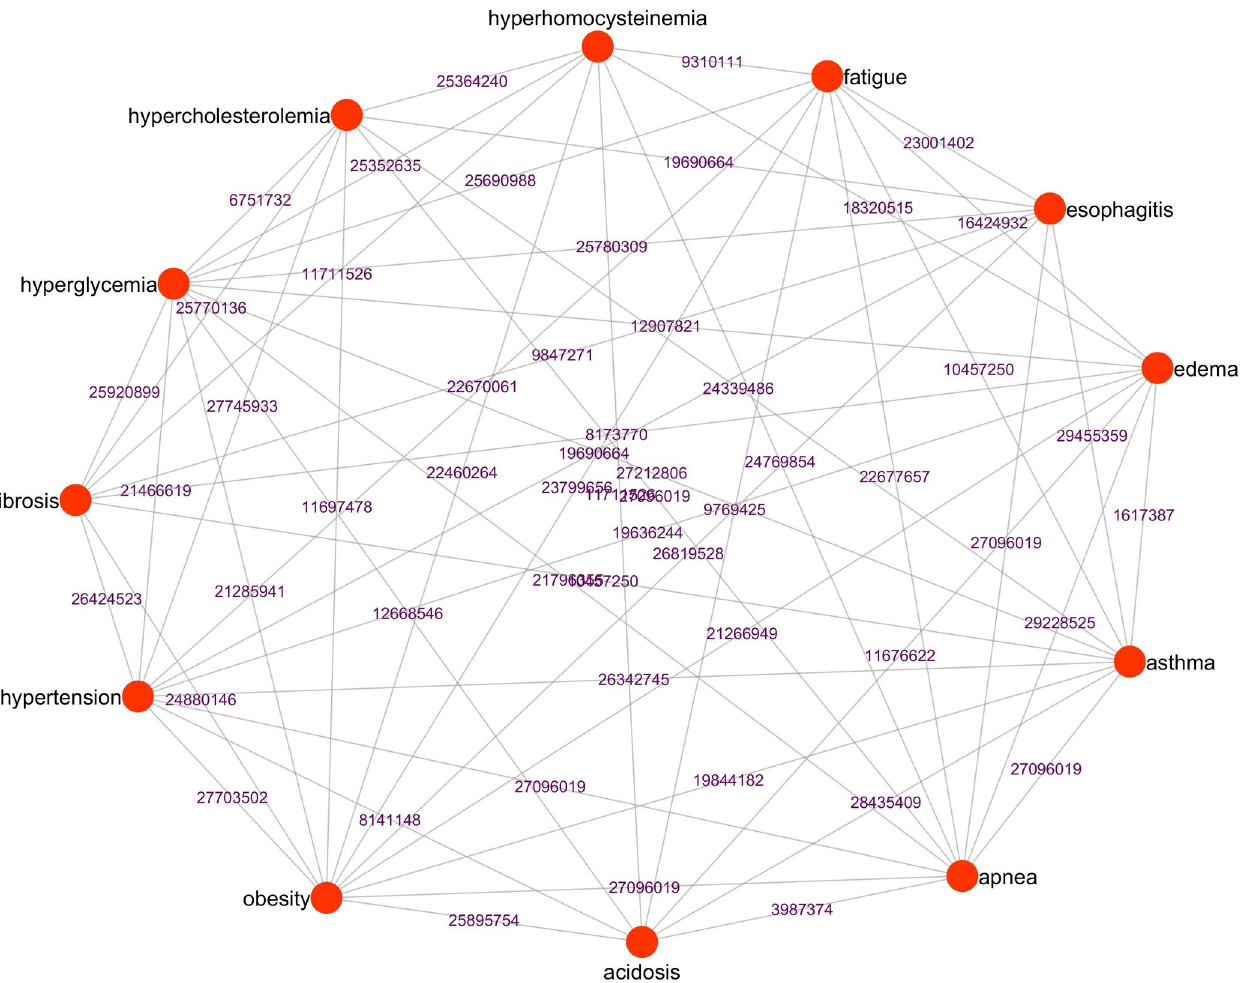
Fig 13. Network view of comorbid association reported in the literature among different diseases of the core DSN. The connection between the different diseases nodes were labelled with their corresponding PubMed Identification number (PMIDs). The complete reference of the labelled PMIDs is given in the S5 Table